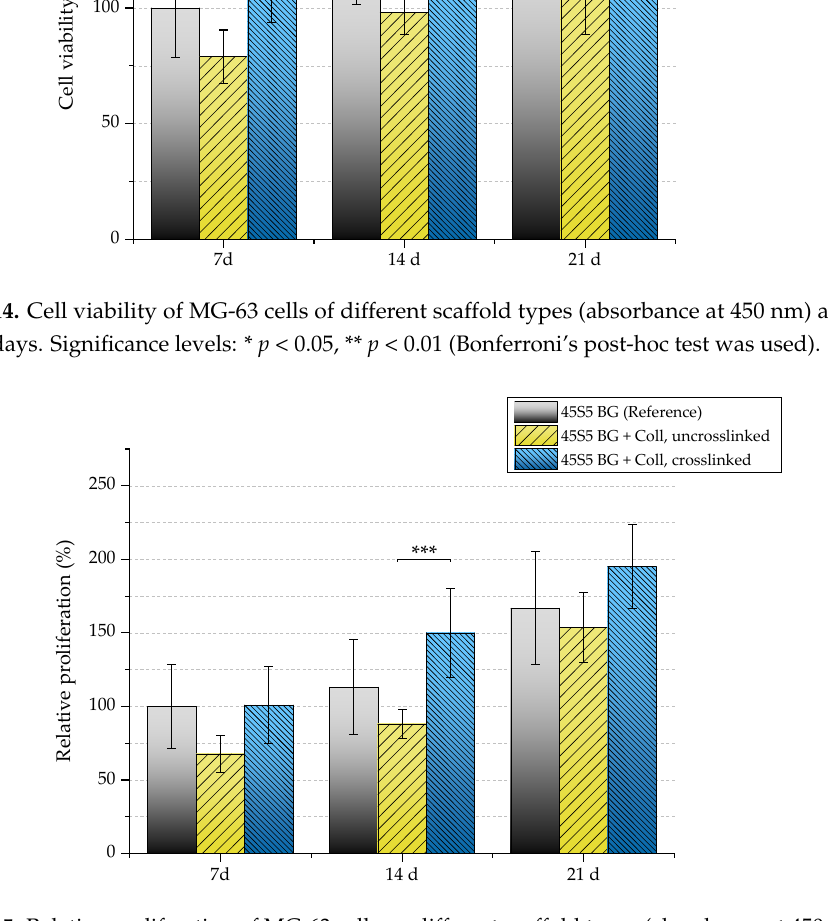
Figure 15. Relative proliferation of MG-63 cells on different scaffold types (absorbance at 450 nm) after 7, 14, and 21 days. Significance level: *** p < 0.001 (Bonferroni’s post-hoc test was used).